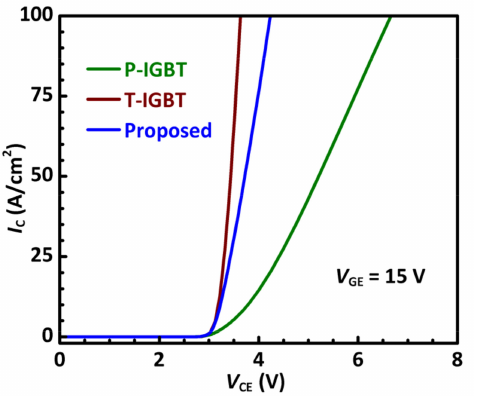
Figure 2. Output characteristics of the P-IGBT, T-IGBT, and the proposed SiC